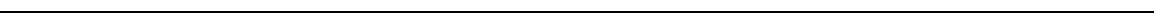
Fig. 7 Stimulation of neuronal activity in adult mice promotes myelination and results in thicker myelin sheaths. a , b Representative immunogold electron microscopic images of the corpus callosum of GFP control ( a ) and hM3Dq/GFP ( b ) mice at P74, following a week of CNO administration (P60 – 66). Myelinated and unmyelinated GFP + axons are pseudo-colored green and red, respectively. c , d Higher magni fi cation of immunogold-positive axons from GFP control ( c ) and hM3Dq/GFP ( d ) mice. e No primary antibody control sections showed almost no gold deposits. f Analysis of the density of GFP + axons in each condition. g Quanti fi cation of the percentage of GFP + axons myelinated in each condition; hM3Dq/GFP mice displayed a signi fi cant increase in the percentage of GFP + axons myelinated relative to GFP only control mice (Welch ’ s corrected unpaired two-tailed t -test: ** P < 0.01, n = 5 mice/condition). h Quanti fi cation of the density of myelinated GFP – axons in each condition. i , j Analysis of myelin thickness ( g -ratios) for GFP + and GFP – axons in GFP control ( i ) and hM3Dq/GFP ( j ) mice. k Comparison of the g -ratios of the GFP + population in GFP control and hM3Dq/GFP mice. l Breakdown of g -ratios for each group by axonal size. Colors of conditions matched for i – k . Two-way ANOVA with Tukey ’ s multiple comparisons test: * P < 0.05, ** P < 0.01, *** P < 0.001; n = 5 mice/condition, ± s.e.m. Scale bars = 5 µ m ( a , b ), 1 µ m ( c , d ), 2.5 µ m ( e ). See also Supplementary Fig.